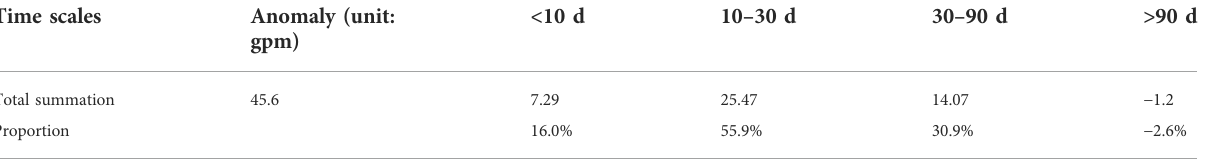
TABLE 1 Contribution of different time-scale anomalies in mid-high latitude key